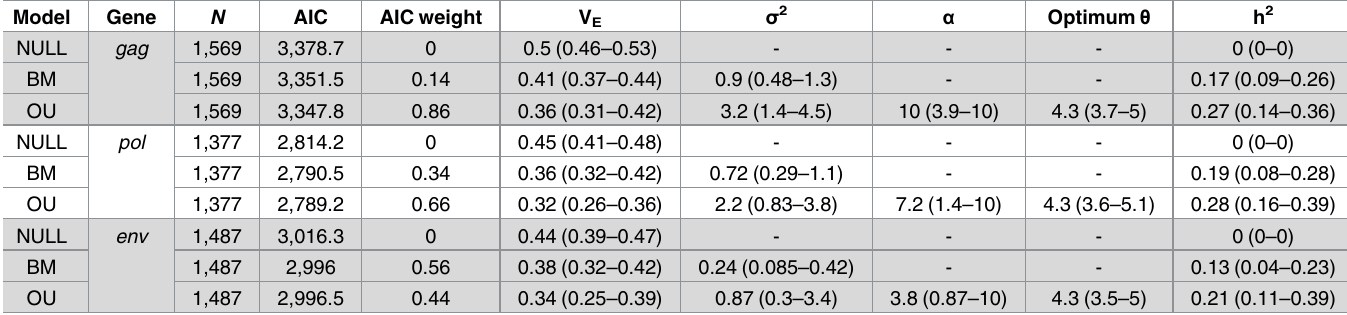
Table 2. Summaryof model fit for GSVL, for subtype B, for each gene. Parameters as in Table